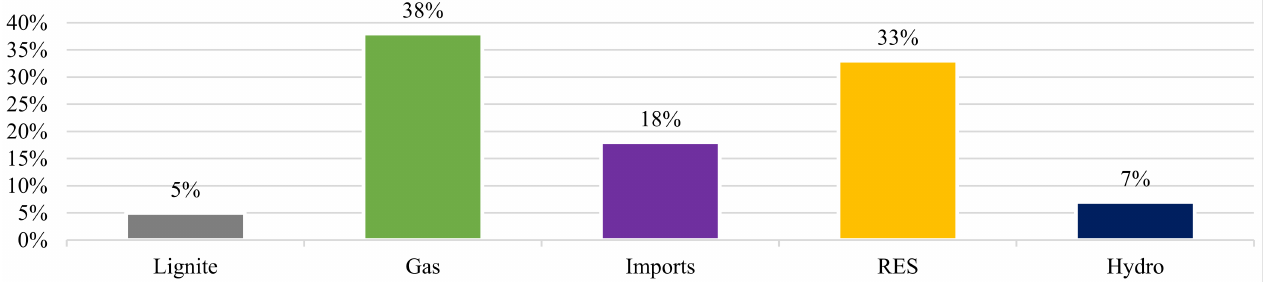
Figure 7. Day-Ahead Market, Sell Volume mix (%), (May 2021), Source: Hellenic Energy Exchange and Authors’ estimations.